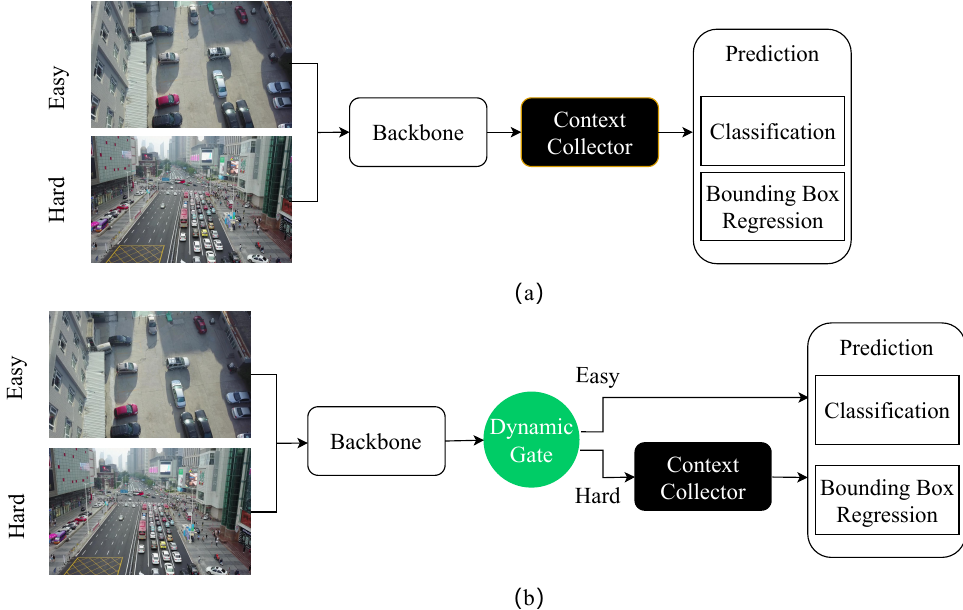
Figure 1. Easy (sparsely distributed and large-size) and Hard (crowded and small-size) inputs for detectors in static and dynamic cases. ( a ) In the static case, a detector executes the operation of context collection to infer inputs regardless of their complexity. ( b ) In the dynamic case, a dynamic gate is introduced to select an appropriate path for different inputs. The detector with the gate module can skip context collection for easy inputs, and only execute context collection for hard